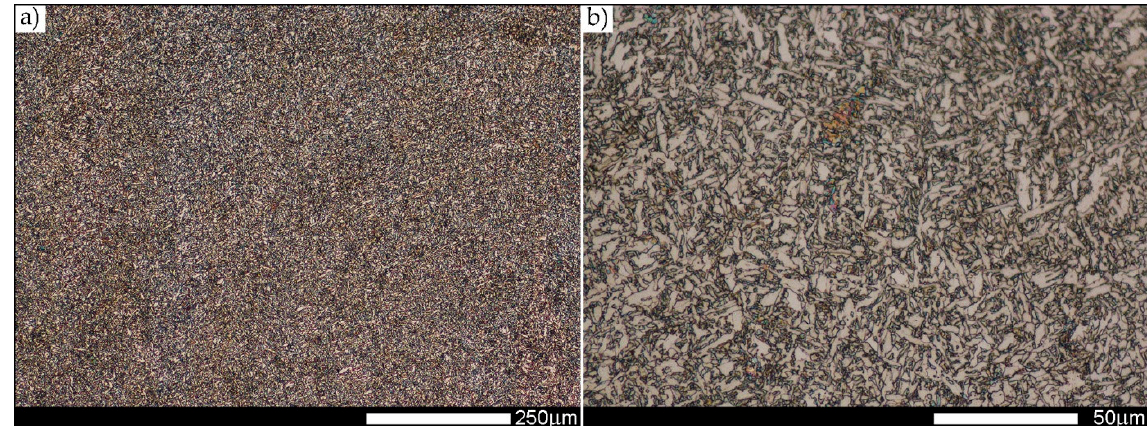
Figure 7. Microstructure of welded joint of Hardox 450 steel in the delivery state (directly after welding)—WM2 zone shown in Figure 2a. ( a ) 100 × ; ( b ) 500 × . Structure of non-equilibrium ferrite grains with troostite precipitates. Light microscopy, etched with 3% HNO 3 .